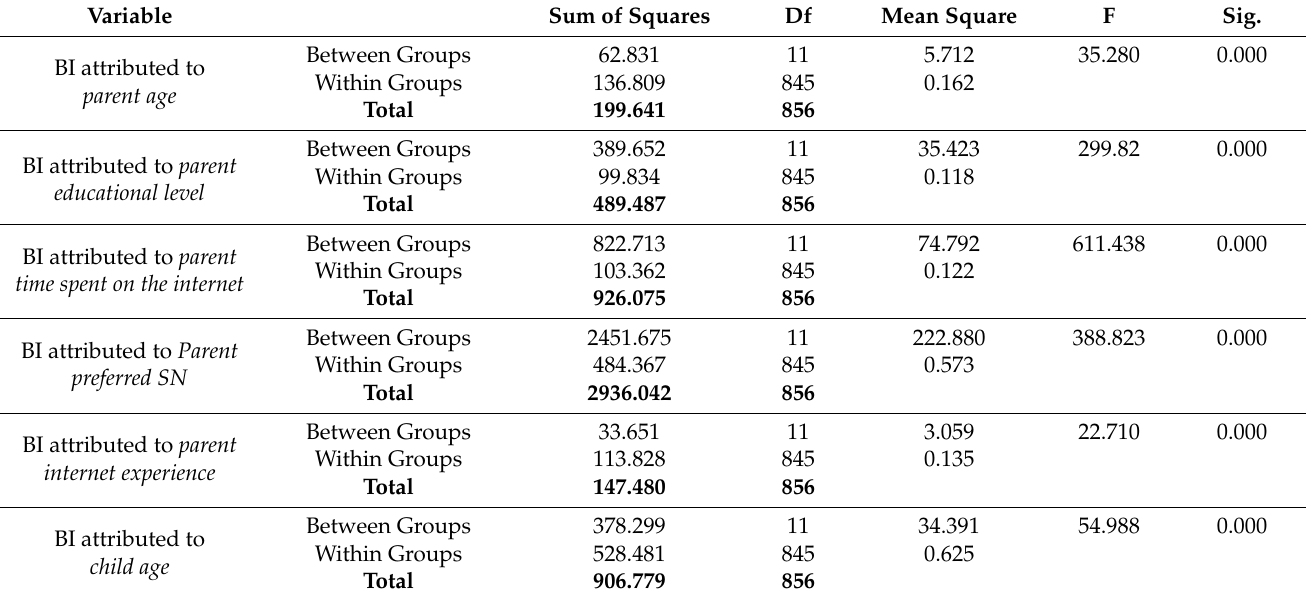
Table 7. ANOVA Analysis of respondent Behavioral Intention (BI) attributed to parent age, parent